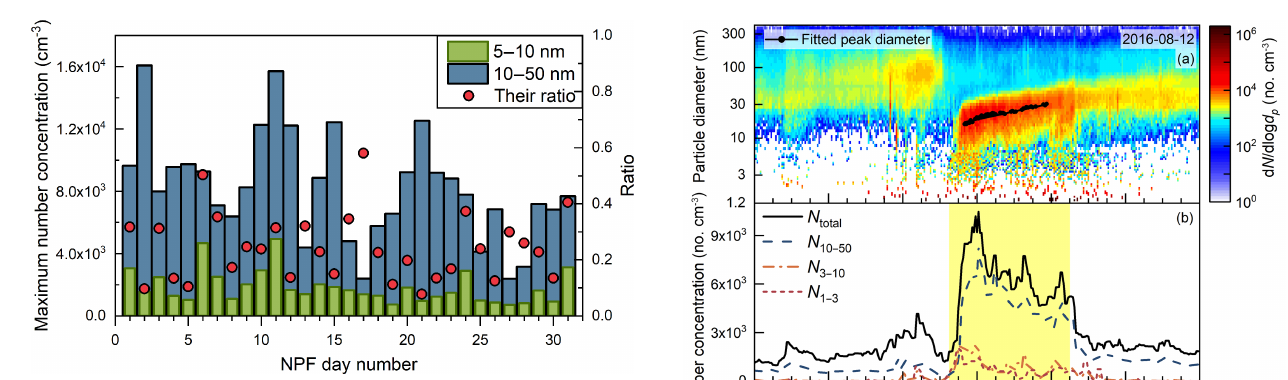
Figure 2. The daily maximum number concentrations of 5–10nm particles and 10–50nm particles during the new particle formation period at the Lulang River valley. Note that the exact time corre- sponding to the two maximum values on each NPF day was not necessarily the same.